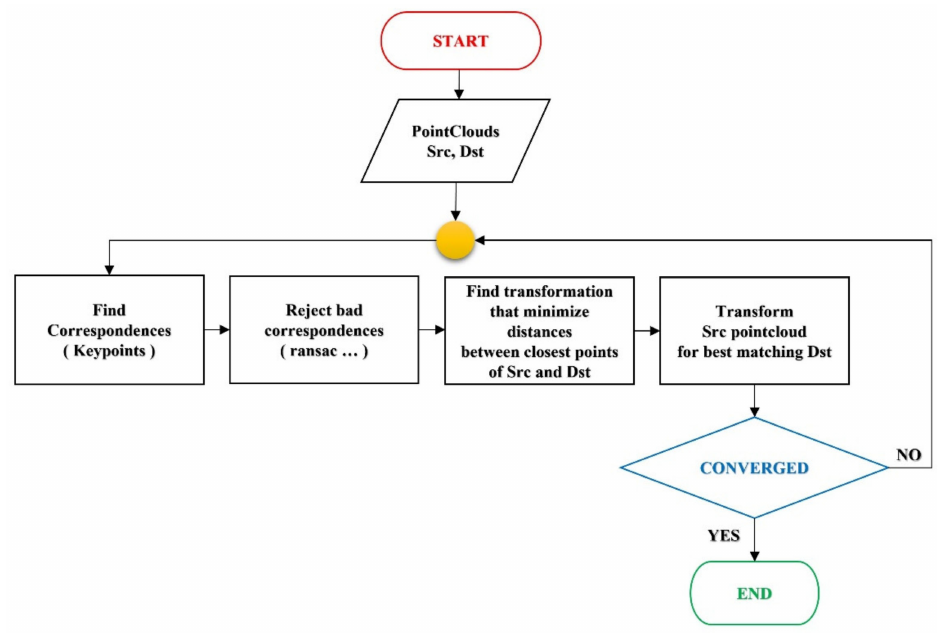
Figure 12. Workflow of the algorithm in ICV for the end